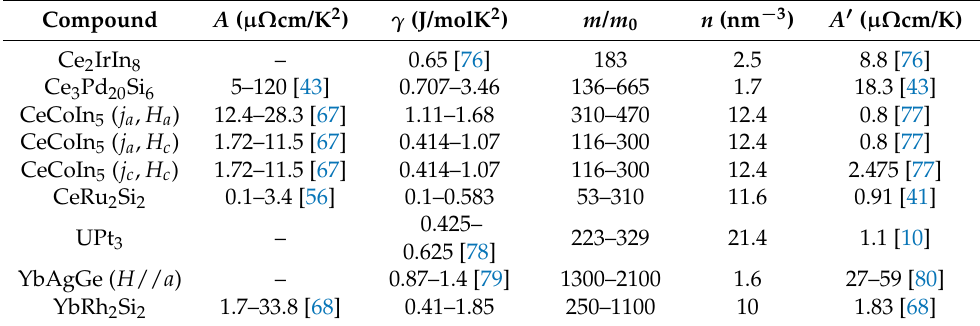
Table 1. Parameters used for Figures 3 and 4. The red (or blue) square represents the largest A coefficient (measured closest to the QCP), the shaded red (or blue) lines the range of A coefficient measured upon moving away from the QCP. The Sommerfeld coefficient γ is estimated from A via the Kadowaki–Wood ratio, unless A data are unavailable. The charge carrier concentrations n and their error bars (where applicable) are taken from Table2. For CeCoIn 5 , several values are listed because the A coefficient is different for in-plane ( H a ) and out-of-plane ( H c ) field, and the A (cid:48) coefficient is different for in-plane ( j a ) and out-of-plane ( j c ) currents. For YbAgGe, the A (cid:48) coefficient changes with field; the two extreme A (cid:48) values are denoted by the two red squares. For CeCoIn 5 ( j ⊥ c ), Figure3 shows the range A (cid:48) = ( 0.8 ± 0.2 ) µ Ω cm/K from [74]. Data for Ce 3 Pd 20 Si 6 refer to the second QCP (near 2T, see Figure 1d) because for the lower field QCP no full data set on single crystals is published